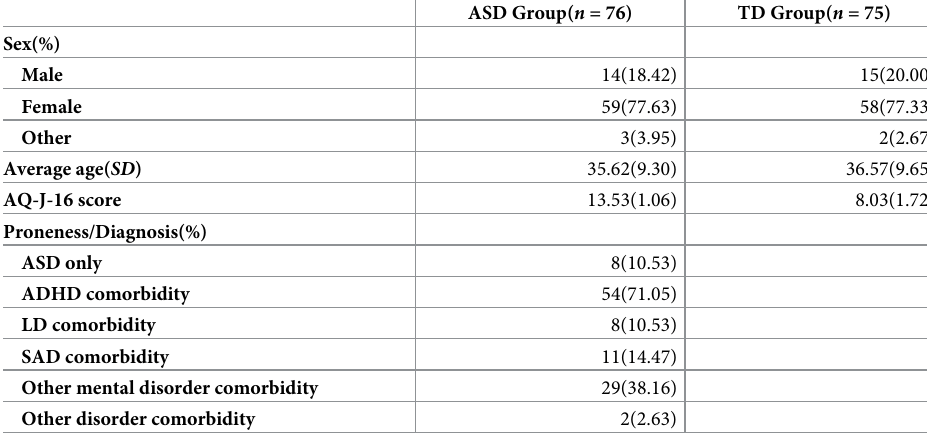
Table 1. Characteristics of the